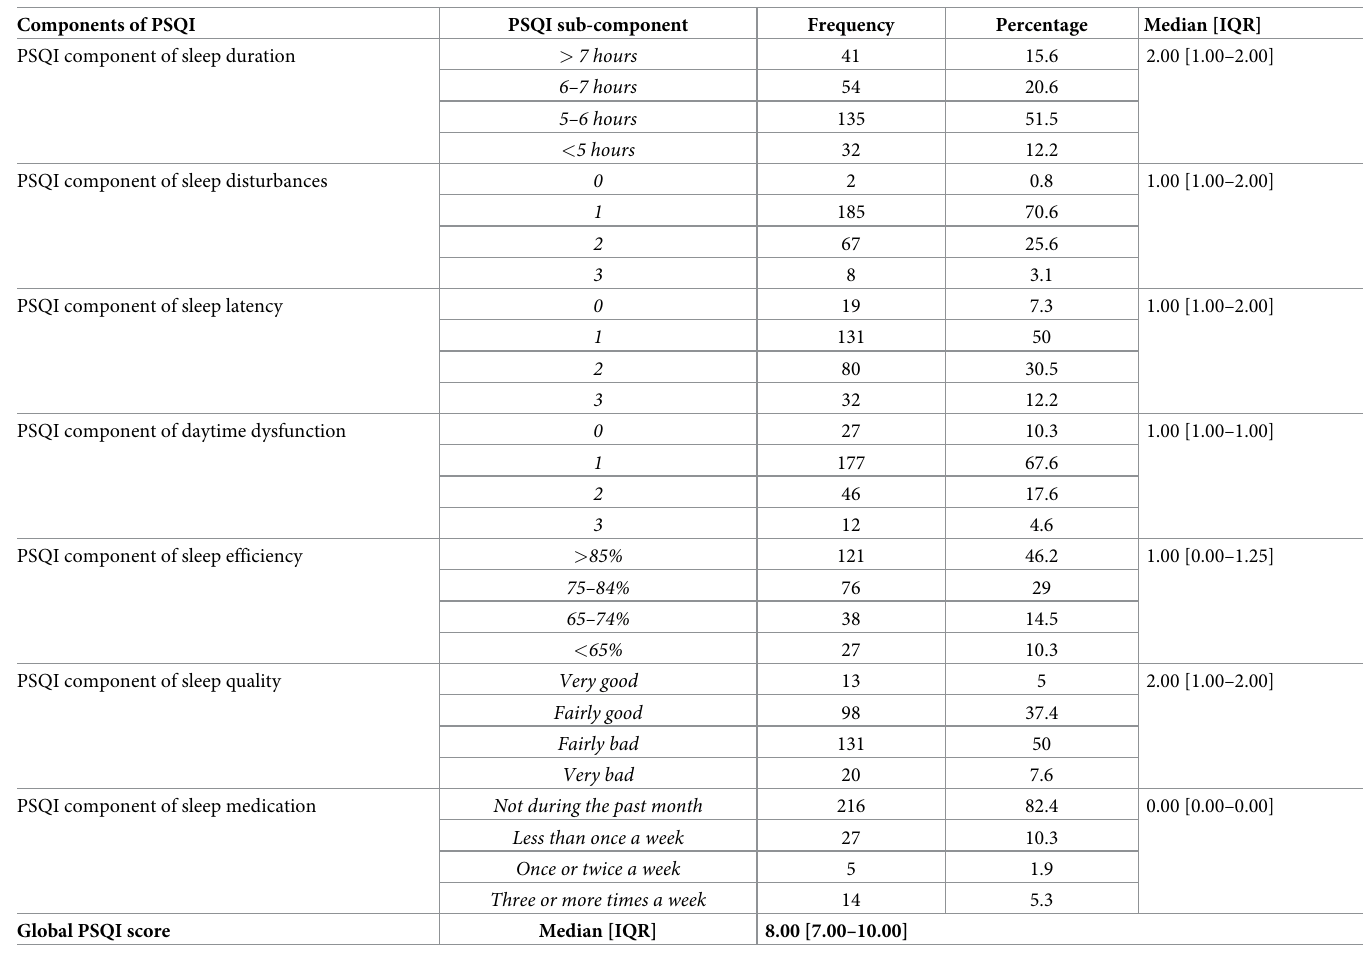
Table 4. Distribution of the Pittsburgh sleep quality index (PSQI) scores (n =